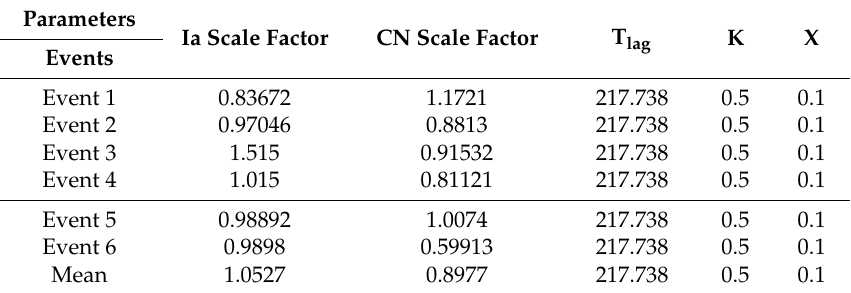
Table 5. Optimized parameter values of each event during